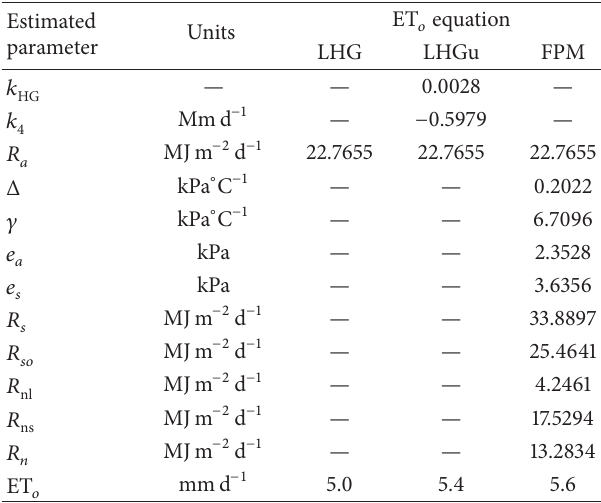
Table 3: Example comparison of the number of intermediate calculations required to estimate ET 𝑜 for a day using LHG,